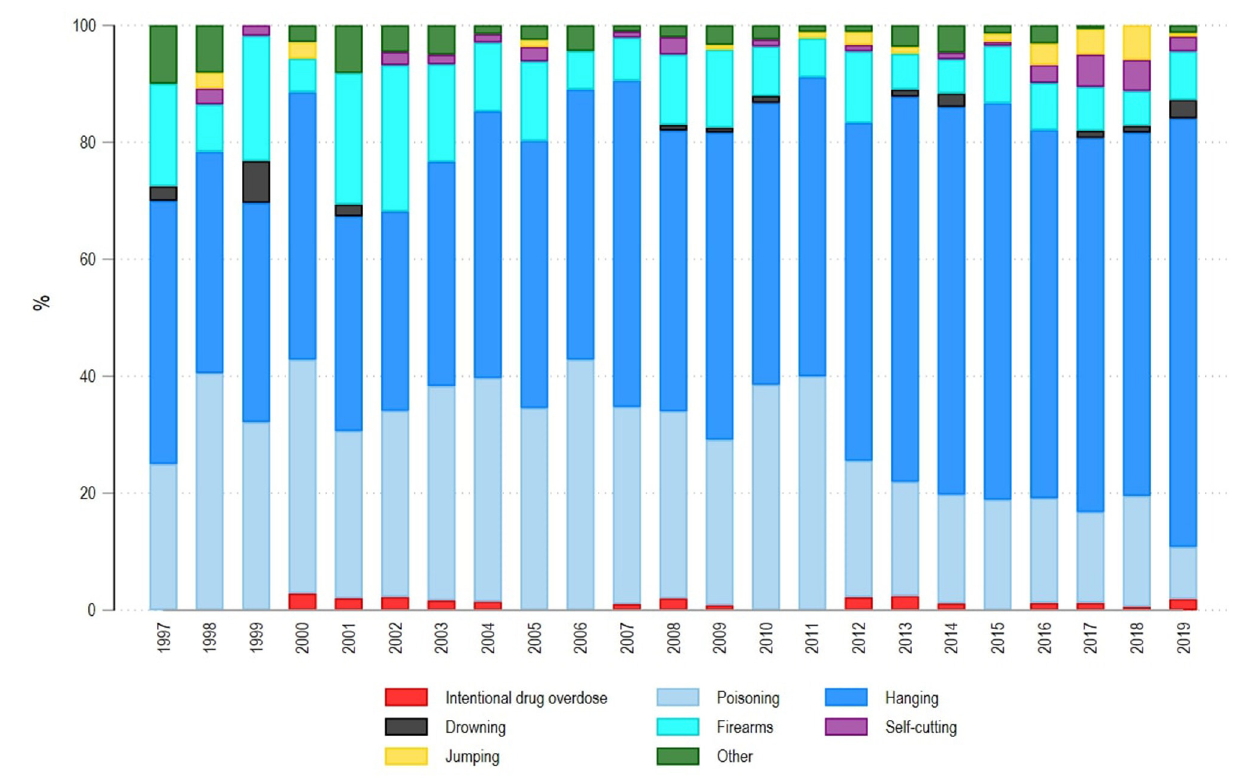
urban areas were two times as high compared to rural areas, while between 2013 and 2019, urban suicide rates were nearly three times higher when compared to rural suicide rates among men. In rural areas, further social support and structure may exist when compared to urban areas, which contribute to a sense of belongingness, a protective factor for suicide